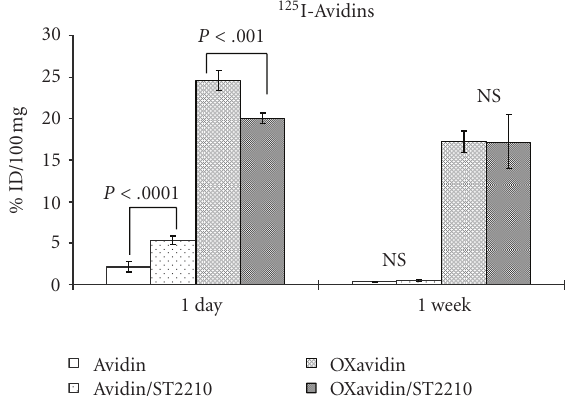
Figure 6: Tissue residence of OXavidin/biotin complex. 125 I- labeled avidin, avidin/ST2210, OXavidin, or OXavidin/ST2210 were injected in the limb of Balb/c mice. At the indicated time points after intramuscular injection mice were sacrificed and samples of treated limb weighted and counted in a gamma counter. Data are expressed as % ID/100mg of tissue. Each point is the average of 5 mice. Bars represent standard deviation. Student’s t test was used for statistical analysis. NS: Not significant.